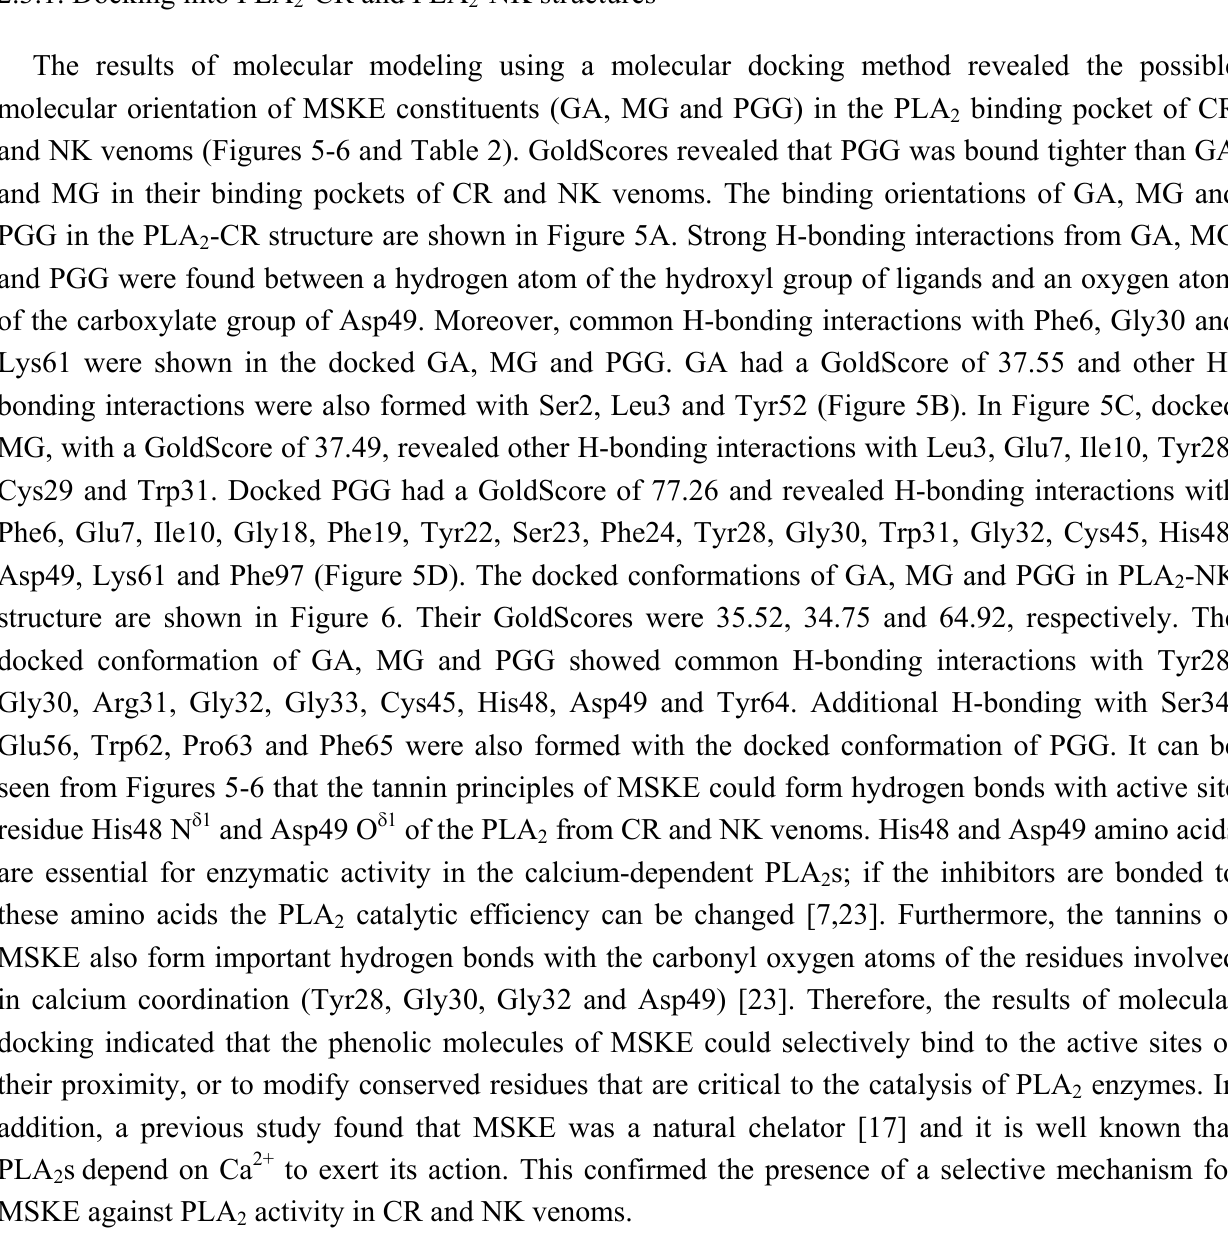
Table 2. GoldScores of ligands docked into LAAO-CR, PLA